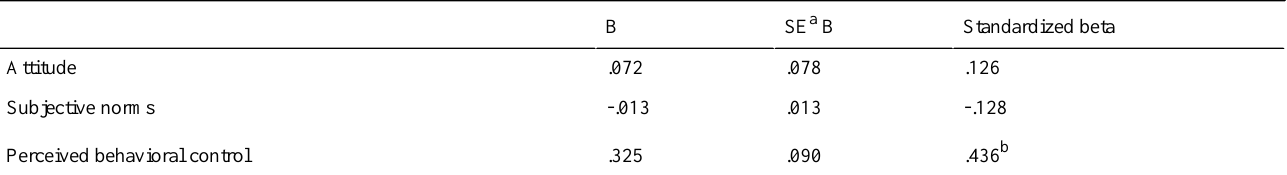
Table 3. Multiple regression predicting intention to complete the online-based